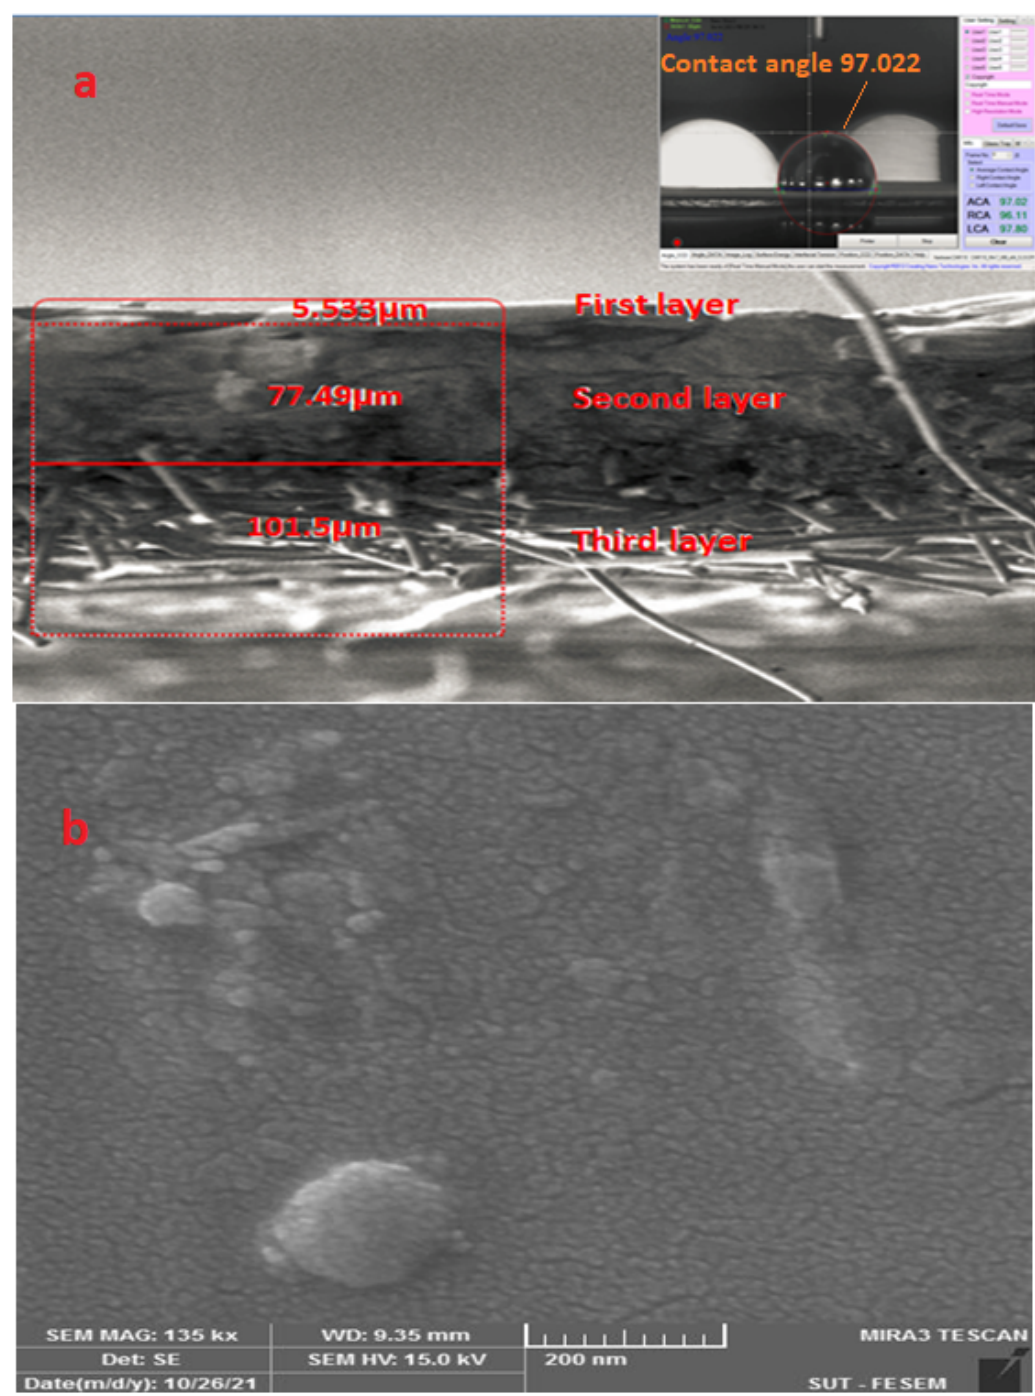
Figure 2. ( a ) Contact angle of PDMS membrane and SEM image of PDMS membrane cross section (200 µm). ( b ) SEM image of PDMS membrane surface.